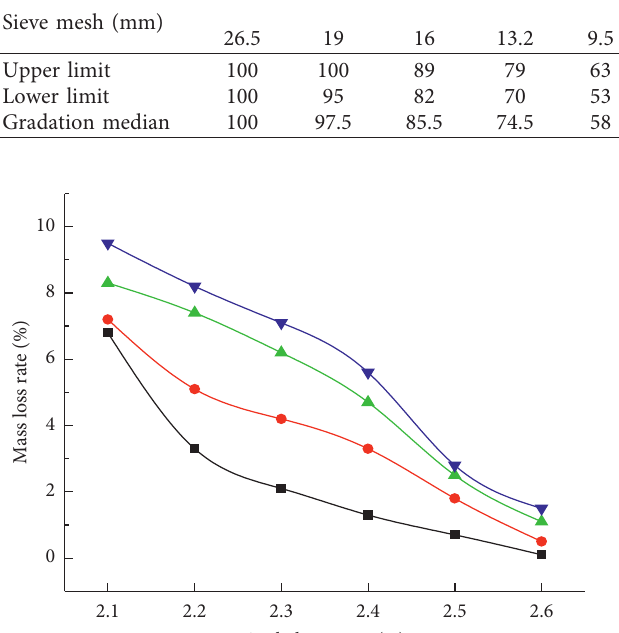
Figure 2: Mass loss rate.